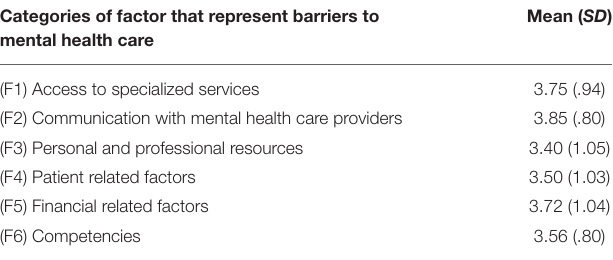
TABLE 5 | Involvement in initiation and treatment of different mental health problems. Current involvement for the following categories